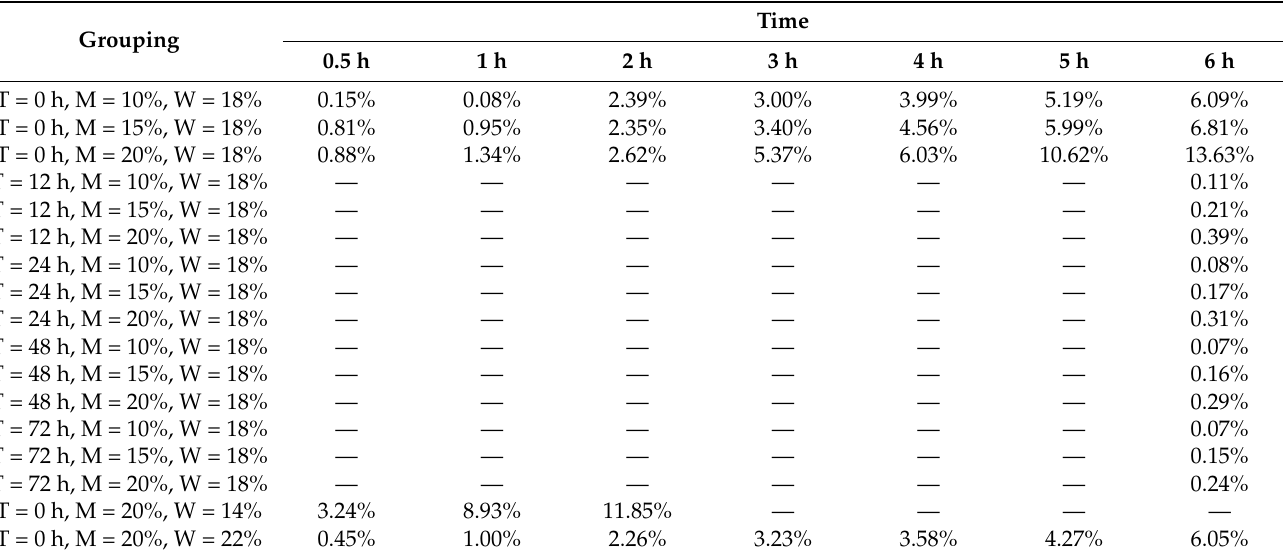
Table 4. The crack ratios of specimens with different slaking